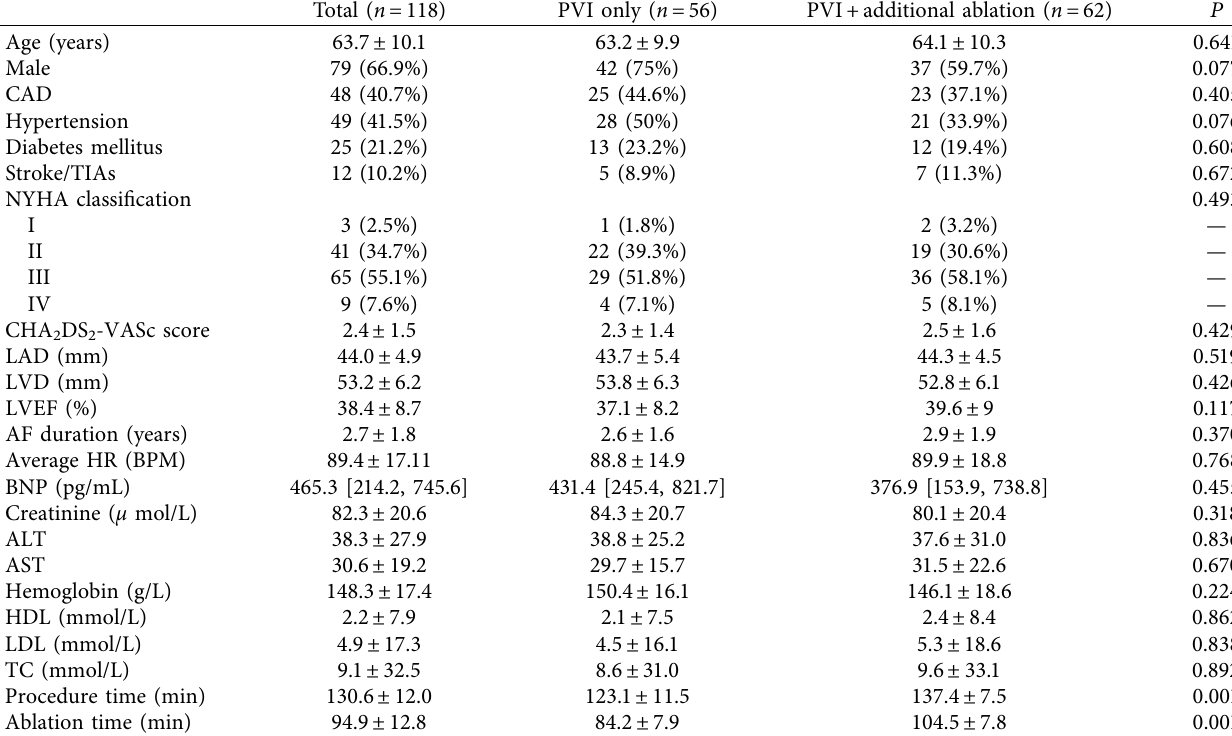
Table 1: Baseline clinical characteristics of the